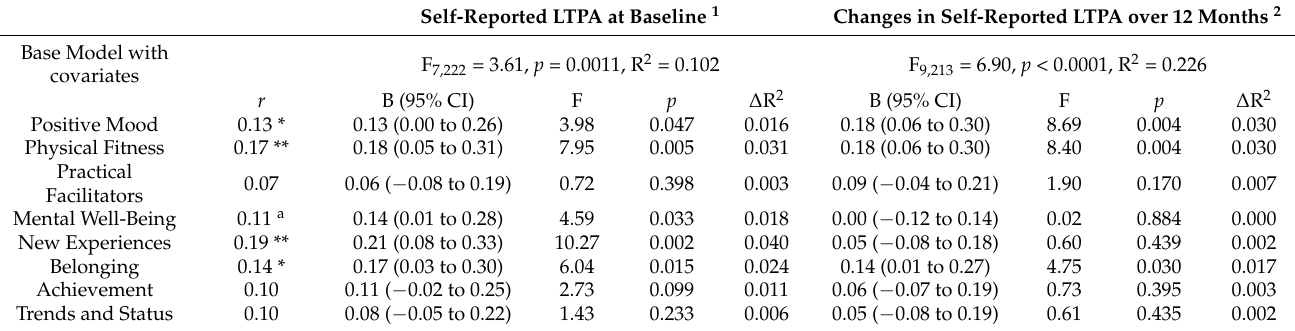
Table 4. The associations between physical activity meaning dimensions and self-reported leisure- time physical activity (LTPA) over 12 months (Pearson correlation coefficients for correlations at baseline ( r ) and covariate adjusted general linear models (B, 95% CI, F, p ) with change in R 2 with reference to the base model with covariates ( ∆ R 2